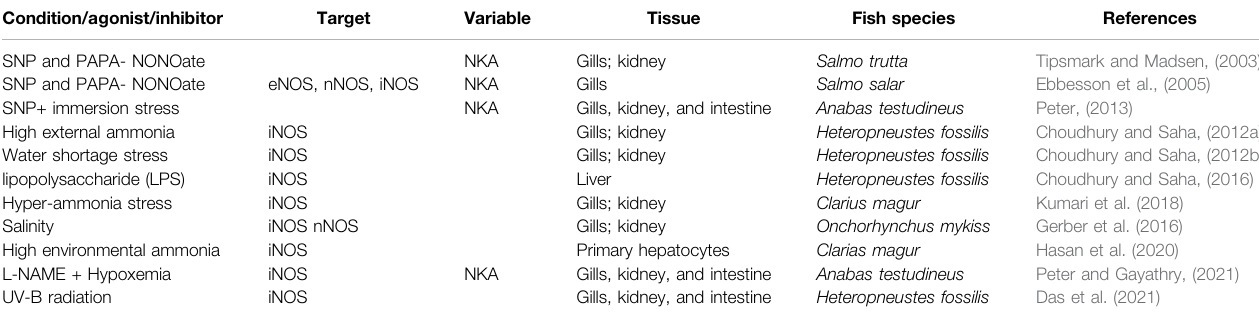
TABLE 1 | Action of NO by the various isoforms of NOS on different tissues of fi sh after treatment with various NO agonists and NOS inhibitors.